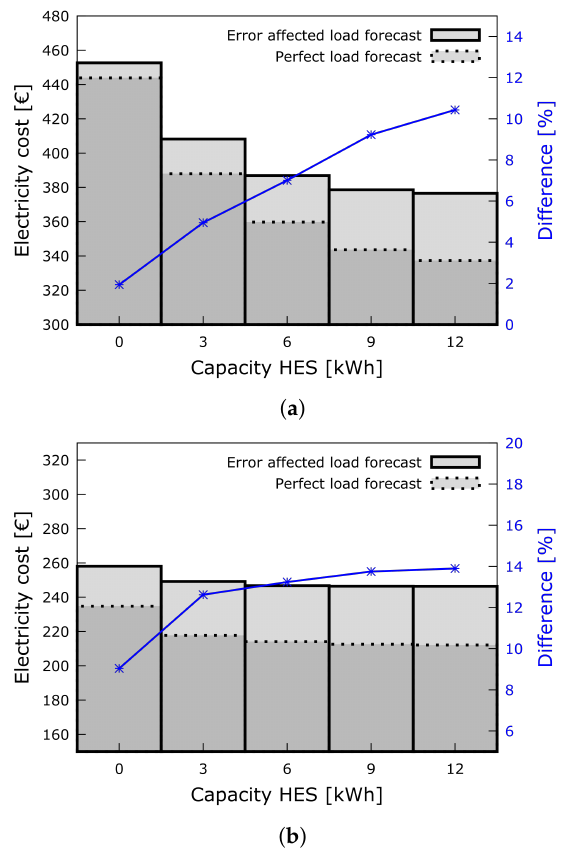
Figure 8. Simulation results from using the EV as a primary vehicle ( a ) and as a secondary vehicle ( b